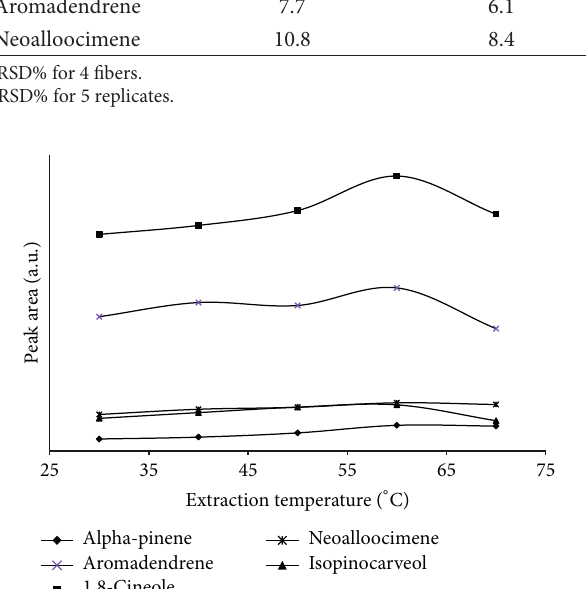
F 4: Optimization of extraction temperature, 0.2g powdered Eucalyptus leaf, and 20min extraction time.